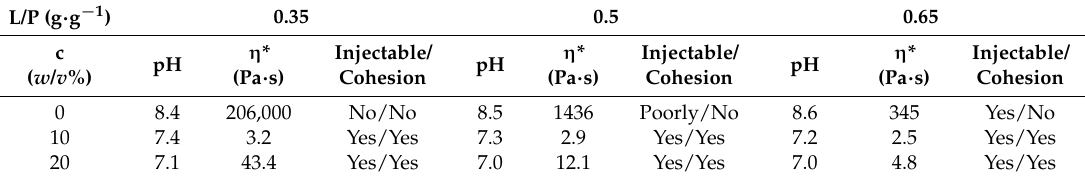
Table 1. The effect of PLGA–PEG–PLGA copolymer concentration (c = 0; 10 and 20 w/v %) and the L/P ratio (0.35; 0.5 and 0.65 g . g − 1 ) at 23 °C on the pH, complex viscosity ( η *) and injectable/cohesion